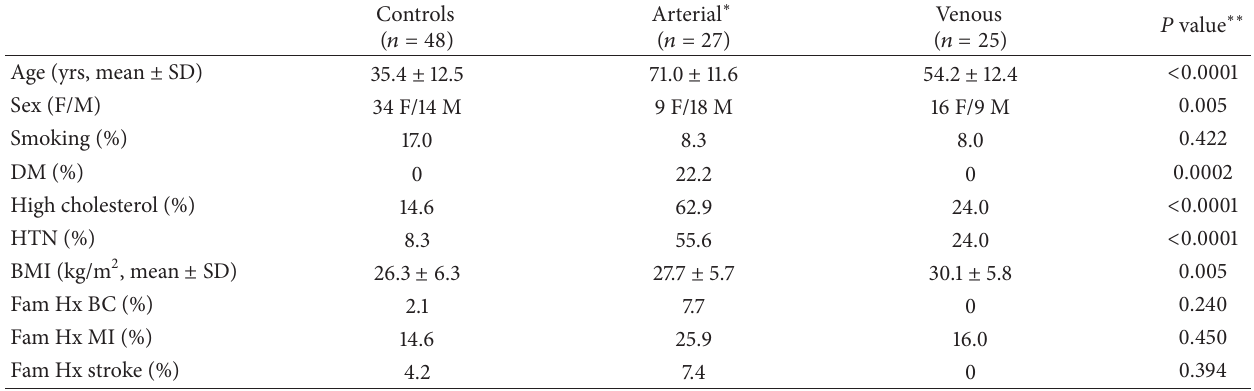
Table 1: Demographic and clinical characteristics of 100 study subjects by vascular disease phenotype.